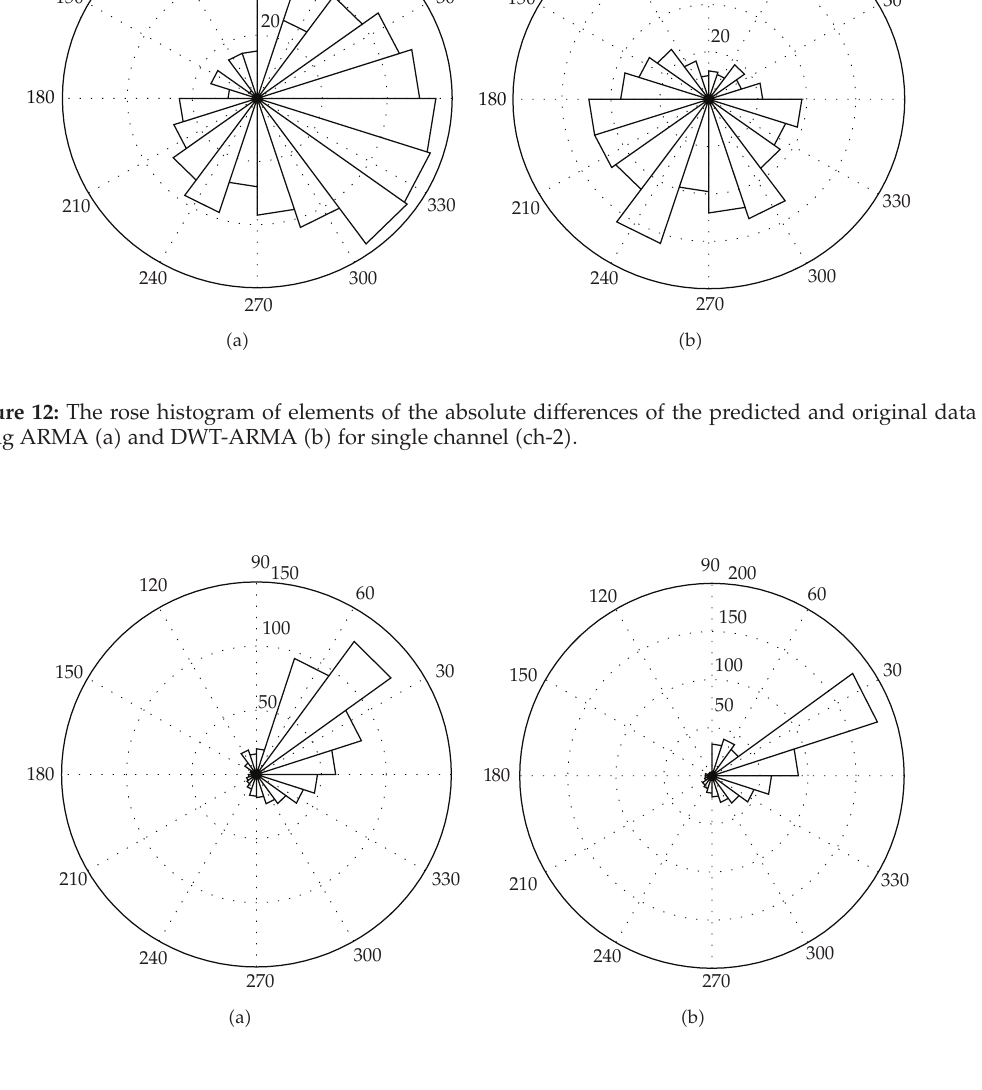
Figure 13: The rose histogram of elements of the absolute di ff erences of the predicted and original data using EMD-ARMA (cid:2) a (cid:3) and MEMD-ARMA (cid:2) b (cid:3) for single channel (cid:2) ch-2 (cid:3)